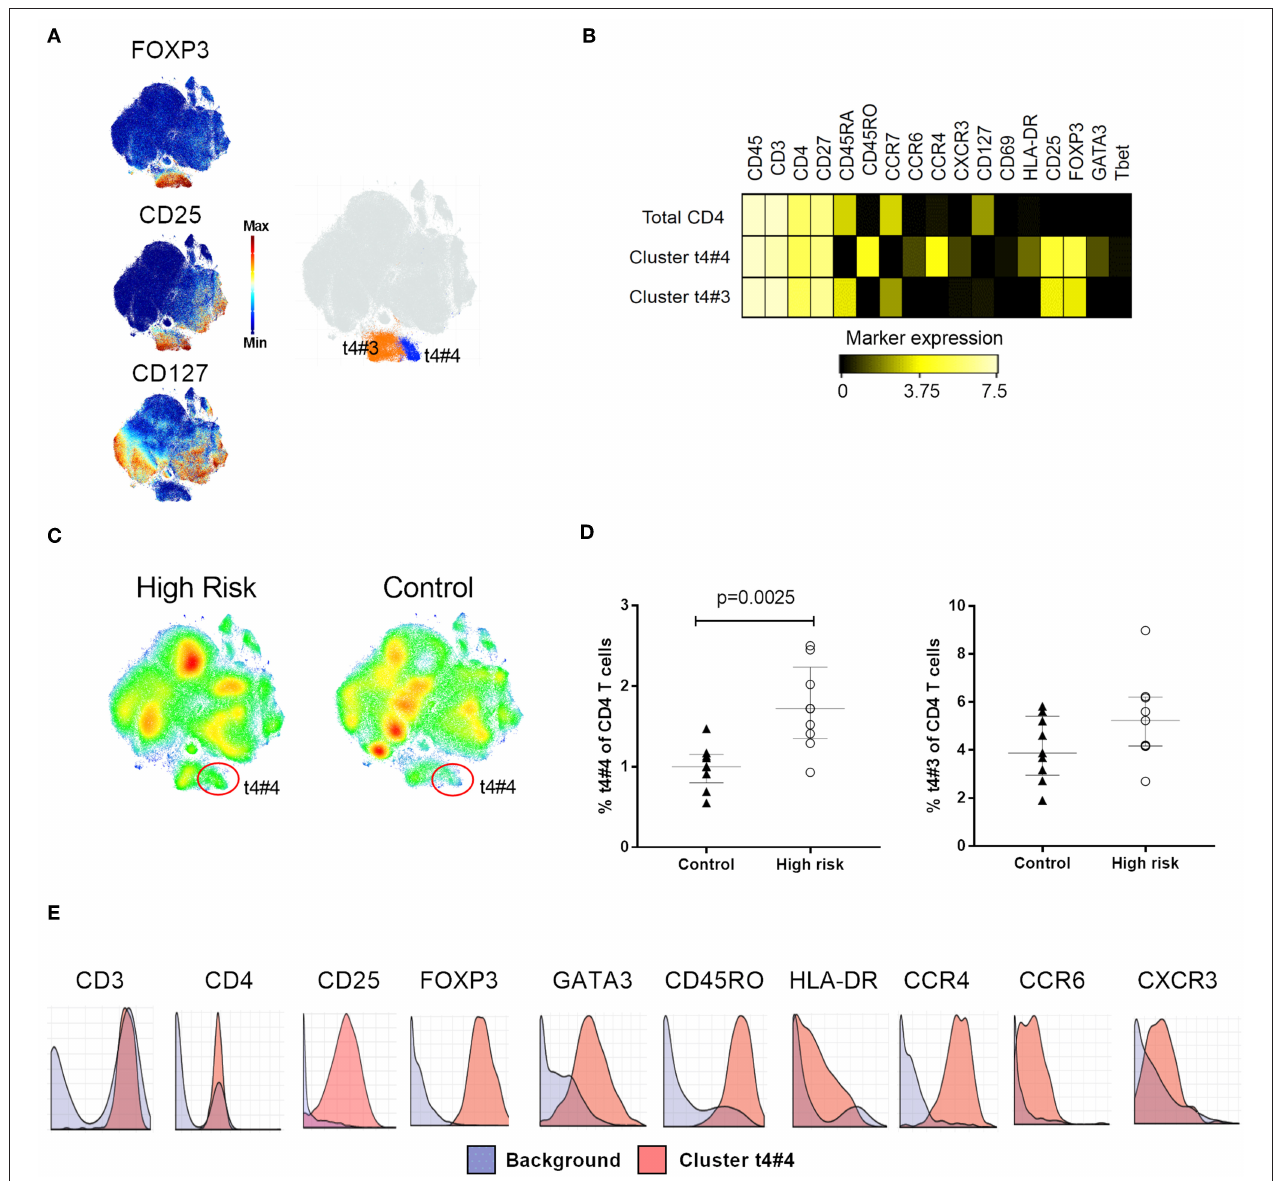
FIGURE 3 | Regulatory T cell phenotyping. (A) Clustering analysis on CD4 + T cells, high expression of FOXP3 and CD25, and absence of CD127 delineated a Treg area with two Treg subsets, t4#3 and t4#4, highlighted as orange and blue, respectively on the t-SNE map. (B) Median expression of relevant phenotype markers that identified Treg subsets t4#3 and t4#4. (C) t-SNE plots illustrating cellular density in individuals with high risk for type 1 diabetes and controls. (D) Percentage of t4#3 and t4#4 subset within total CD4T cells in high-risk individuals (white circles) and controls (black triangles). (E) Citrus-generated histograms showing distribution of phenotype markers expressed by cluster t4#4 (red) in relation to the background expression (blue). Background was determined by all the cells that do not belong to clusters significantly different between the groups, i.e., whole PBMC. Dots represent individual samples. Error bars show median ± interquartile range. Median expression values were transformed using arcsinh function in a cofactor of 5. p -values for differences between groups were determined using Mann-Whitney U-test. p < 0.05 was considered